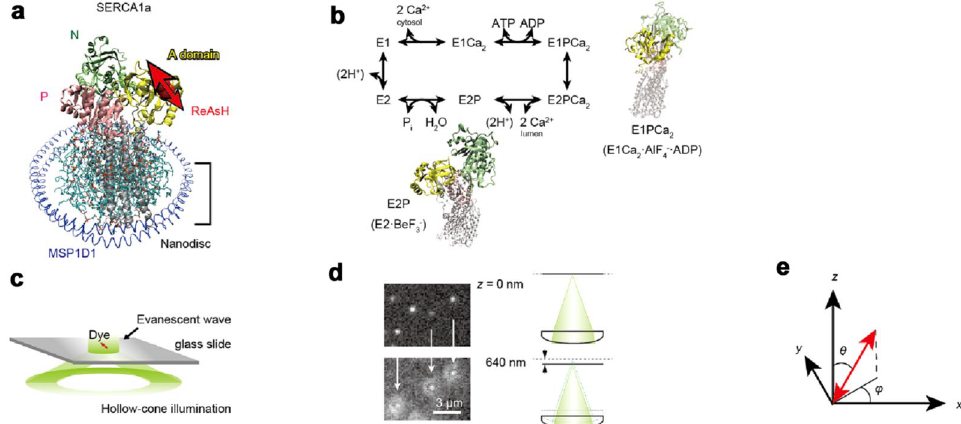
Figure 1. Schematic of SERCA1a molecule and defocused orientation imaging. ( a ) A schematic of the experimental setup. A single SERCA1a molecule was embedded in the nanodisc. Yellow, green, and pink domains represent A, N, P-domains, respectively. Fluorophore ReAsH is attached to its A-domain. Blue structure represents the membrane scaffold protein of the nanodisc (MSP1D1). Double headed red arrow represents presumed dipole moment of ReAsH. ( b ) Reaction scheme of the Ca 2+ -ATPase and the crystal structures in the E 1PCa 2 ( E 1Ca 2 ·AlF 4 − ·ADP) and E 2P ( E 2·BeF 3 − ) states (PDB ID code: 1T5T and 2ZBE; Two molecules were aligned using M7-M10 helices). A-domain undergoes a ~ 90° rotation during E P isomerization. ( c ) A schematic of the isotropic total internal reflection fluorescence microscopy (iTIRF). The laser beam comes from all directions as a hollow-cone of illumination. The evanescent field produced by the iTIRF contains all polarization components along x -, y -, and z -directions, thus single fluorophores are efficiently excited even though each fluorophore orients in a different direction. ( d ) Image and schematic of the defocused imaging.